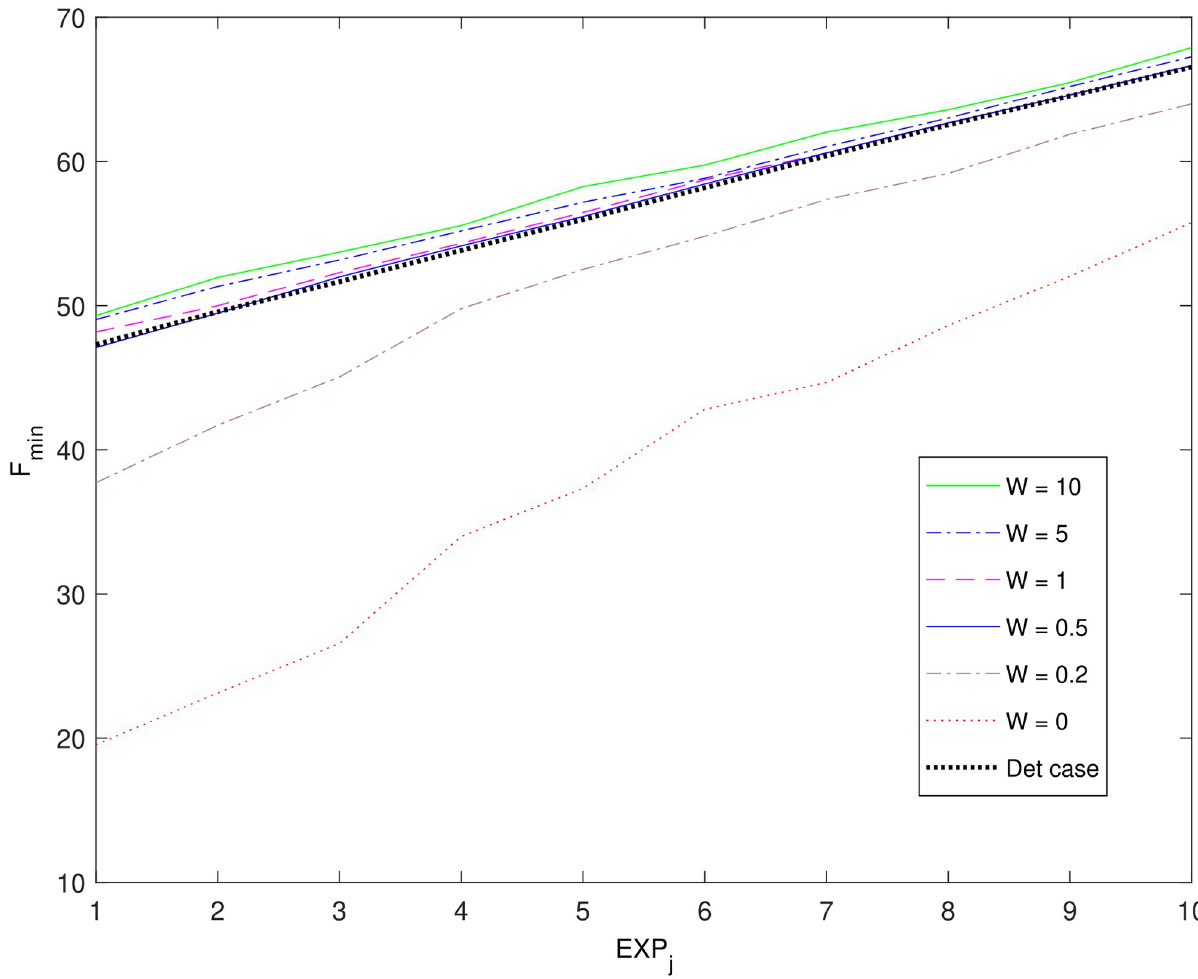
Fig 4. F results for 10 different experiments ( EXP min j =